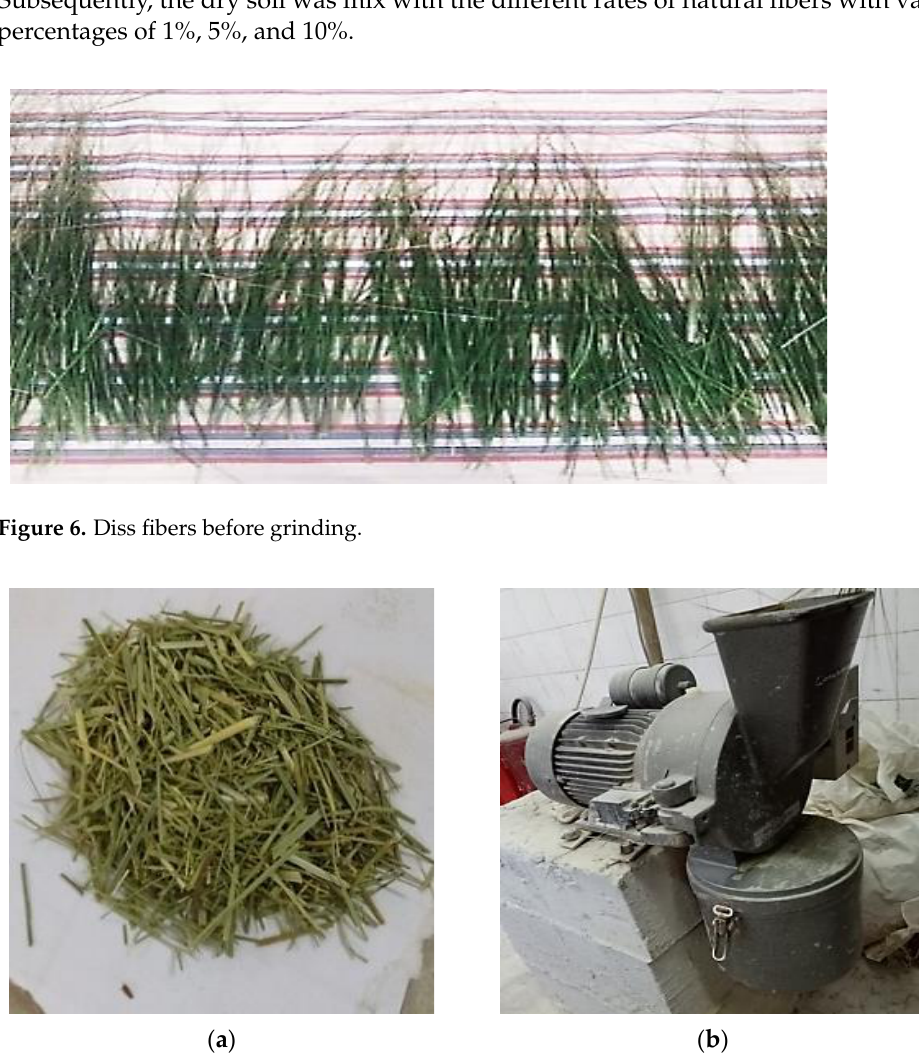
Figure 7. Preparation and visualization of Diss fibers used: ( a ) Diss fibers after grinding and ( b ) grinder.